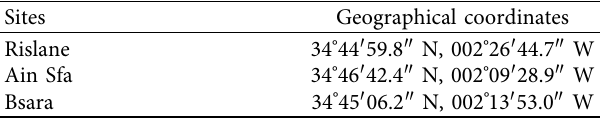
Table 1: Geographical coordinates of “Beldi” almond three sites used for collecting plant materials in the eastern region of Morocco. Sites Geographical